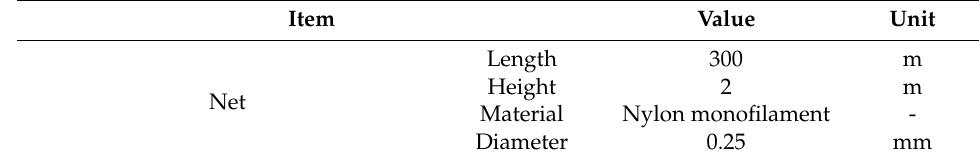
Figure 1. 2D views of entire bottom-set gillnet ( a ) and the net assembly ( b ). Table 1. Material properties and design parameters.